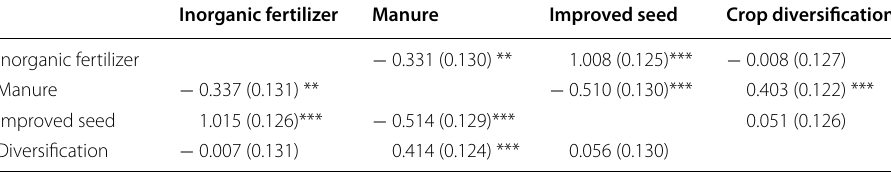
Table 5 Simple probit models showing relationships between technologies Inorganic fertilizer Manure Improved seed Crop diversification Inorganic fertilizer 0.331 (0.130) ** 1.008 (0.125)*** 0.008 (0.127) − − Manure 0.337 (0.131) ** 0.510 (0.130)*** 0.403 (0.122) *** − − Improved seed 1.015 (0.126)*** 0.514 (0.129)*** 0.051 (0.126) − Diversification 0.007 (0.131) 0.414 (0.124) − Coefficient are shown with standard errors in parentheses; ***, **, * significant at 1, 5, and 10% level, respectively